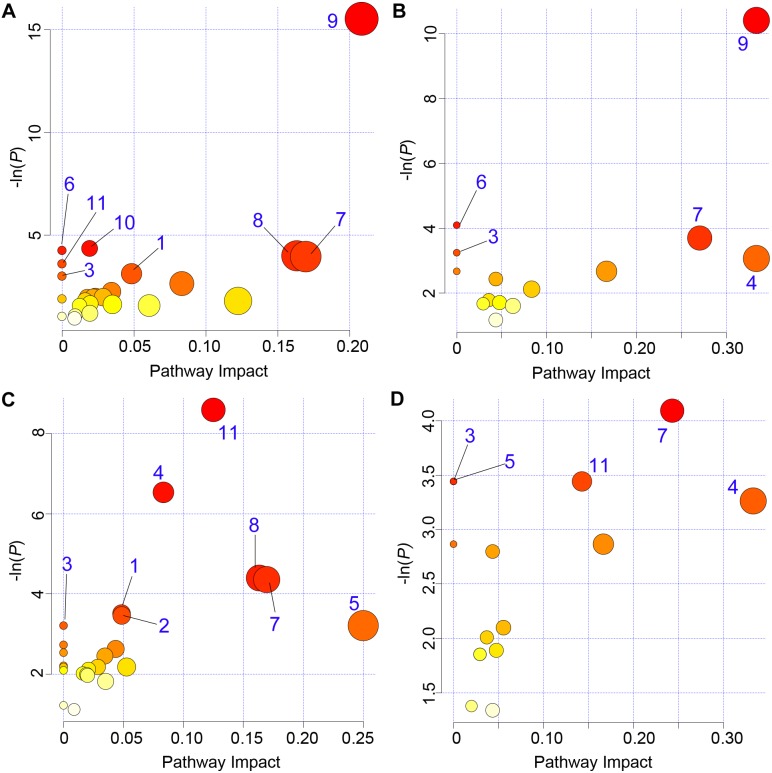
Metabolic pathway analysis.The metabolic pathways are represented as circles according to their scores from enrichment (vertical axis) and topology analyses (pathway impact, horizontal axis) using MetaboAnalyst 2.0 [56]. Darker circle colors indicate more significant changes of metabolites in the corresponding pathway. The size of the circle corresponds to the pathway impact score and is correlated with the centrality of the involved metabolites. The metabolic pathways involved in age differences are shown in panels A and B, and the pathways perturbed due to the Callipyge mutation are summarized in panels C and D. Panels A and C were generated using the Homo sapiens library, while the Bos taurus library was selected for production of panels B and D, respectively. Pathways were annotated by numbering when the P values calculated from the enrichment analysis were <0.05. The annotated pathways include: 1, Aminoacyl-tRNA biosynthesis; 2, Arginine and proline metabolism; 3, Biotin metabolism; 4, Cyanoamino acid metabolism; 5, D-Glutamine and D-glutamate metabolism; 6, Galactose metabolism; 7, Glycine, serine and threonine metabolism; 8, Lysine degradation; 9, Methane metabolism; 10, Nitrogen metabolism; 11, Synthesis and degradation of ketone bodies. The color of each metabolic pathway is related to the P value obtained from enrichment analysis and its size represents the fold enrichment score i.e. −ln(P).